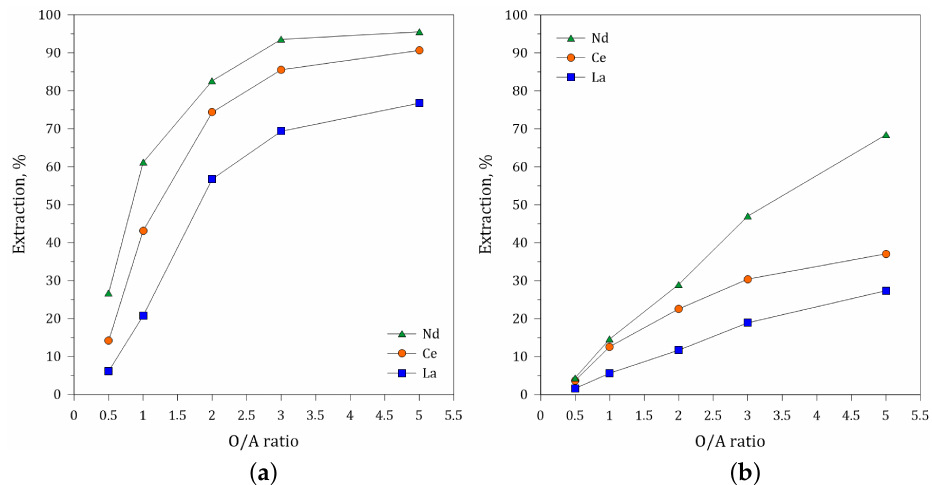
Figure 19. Effect of the O/A ratio on the extraction of Ce , La and Nd with: D 2 EHPA ( a ) and Cyanex 572 ( b